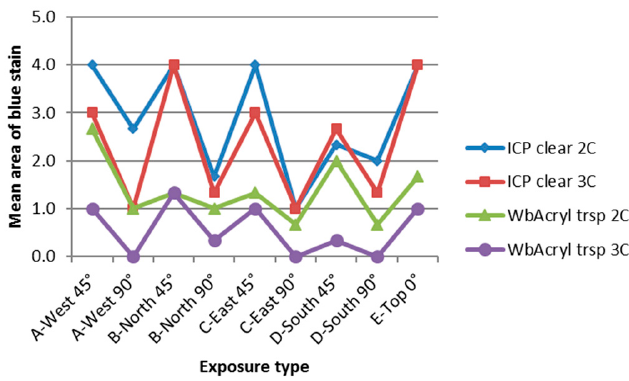
Figure 8. Mean intensity of blue stain after six months of exposure (February 2016) using the MFER.